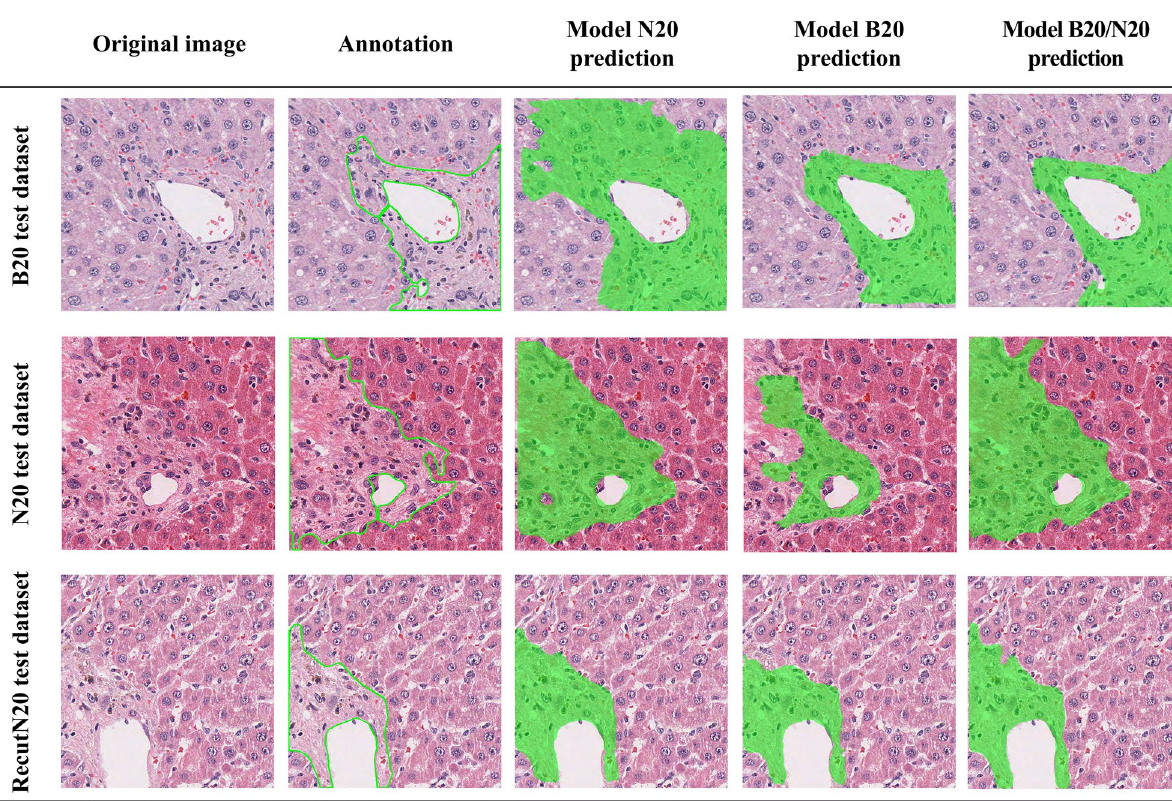
Figure 4. Prediction results of each model for the test dataset of its own and other datasets.